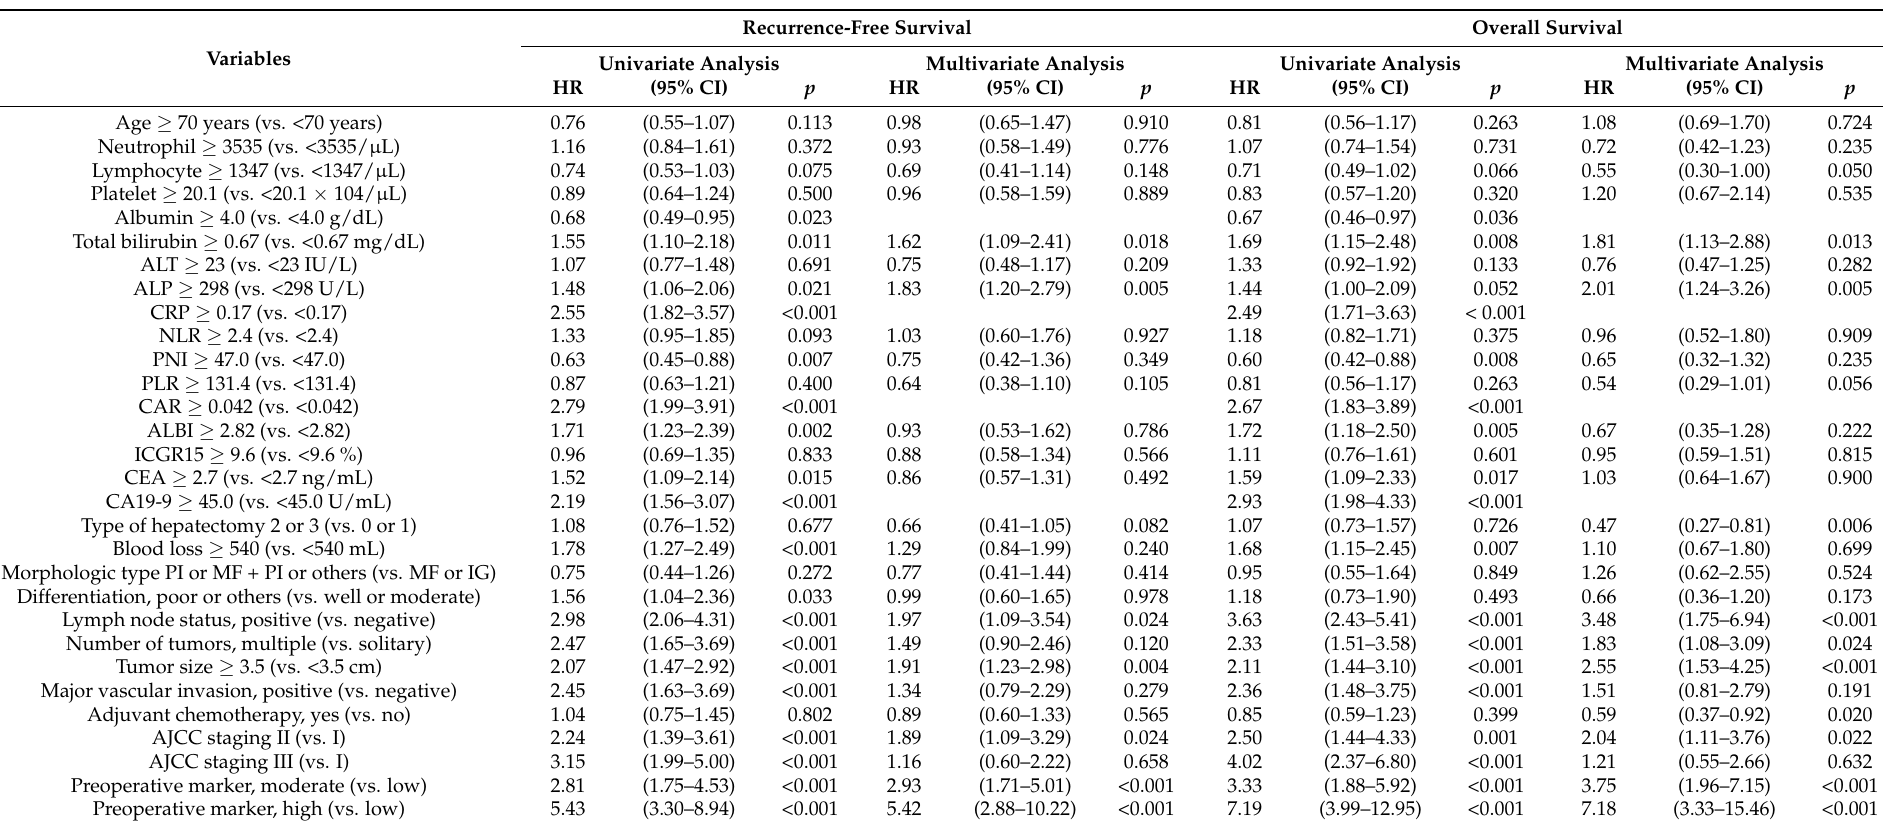
Table 2. Cox proportional hazards regression analysis for recurrence-free survival and overall survival in patients with intrahepatic cholangiocellular carcinoma who underwent hepatic resection. Recurrence-Free Survival Overall